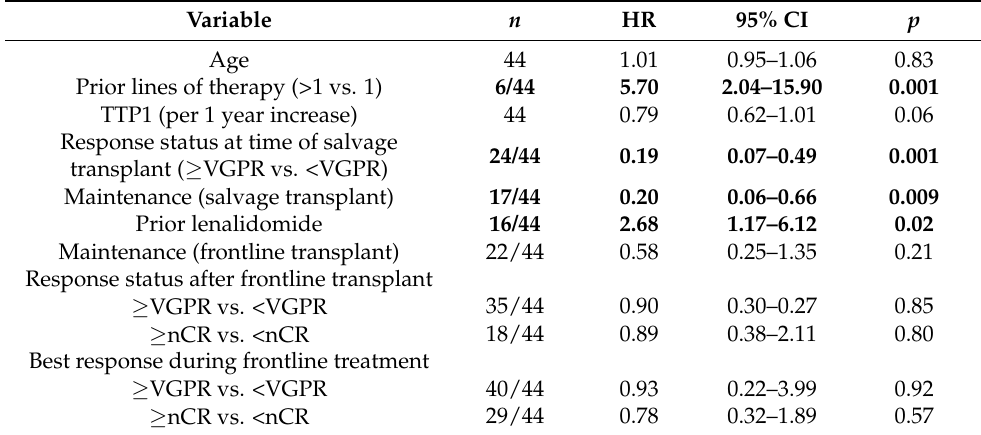
Table 2. Univariate Cox regression analysis of prognostic impact on progression-free survival (PFS) from salvage HDCT/ASCT.